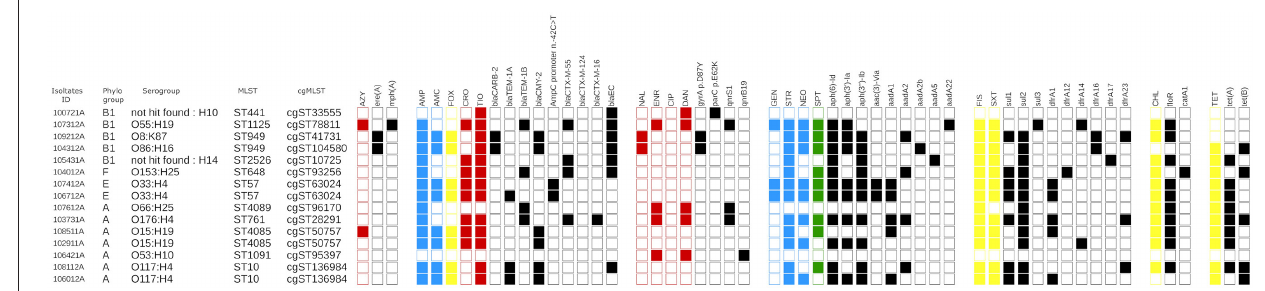
FIGURE 4 | Phylogenic, phenotypic, and genotypic characteristic of 15 isolates from the generic collection from 87 dairy farms from Québec, Canada in 2020–2021 determined by whole genome sequencing. In red, critical high priority antimicrobials for human medicine, AZM, azithromycin; CRO, ceftriaxone; TIO, ceftiofur; CIP, ciprofloxacin; DAN, danofloxacin; ENR, enrofloxacin; NAL, nalidixic acid; in blue, critical priority antimicrobials for human medicine; GEN, gentamicin; NEO, neomycin; STR, streptomycin; AMC, amoxicillin-clavulanic acid; AMP, ampicillin; MEM, meropenem. In yellow, high priority antimicrobials for human medicine, CHL, chloramphenicol; FOX, cefoxitin; FIS, sulfisoxazole; SXT, trimethoprim-sulfamethoxazole, FOL, combined folate inhibitors; TET, tetracycline; in green, antimicrobials important for human medicine, SPT, spectinomycin. The importance of antimicrobial for human medicine was defined according to World Health Organization. The